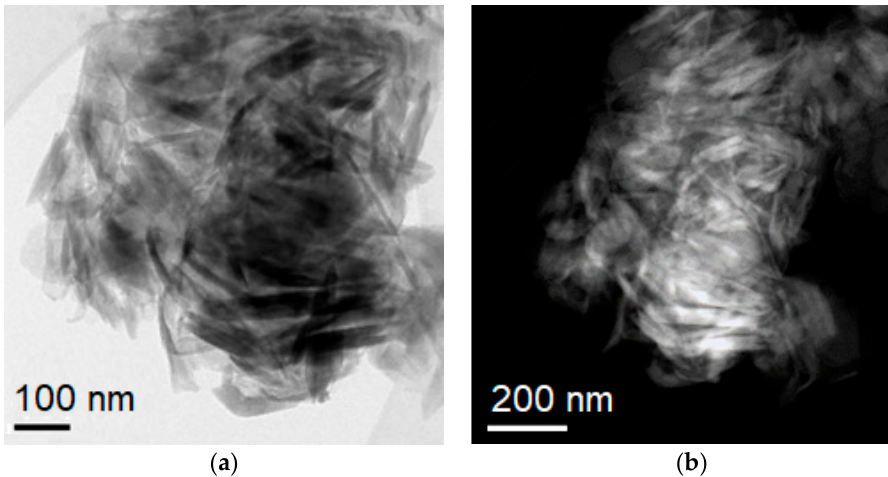
Figure 4. TEM images of raw halloysite samples showing halloysite nanoplates and nanotubes: ( a ) bright field (BF); ( b ) dark field (DF).